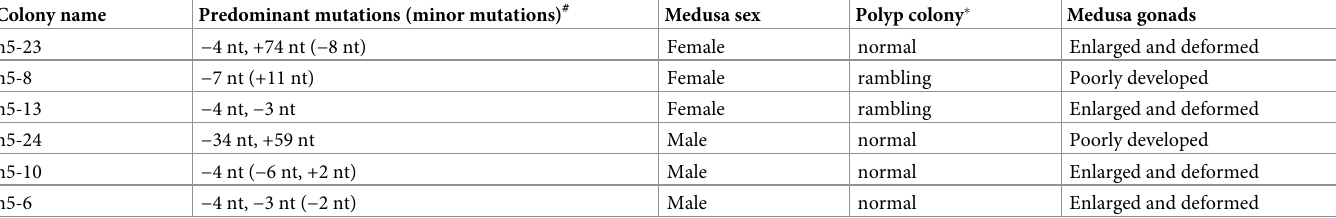
Table 1. Characteristics of MIHR mutant colonies. Colony